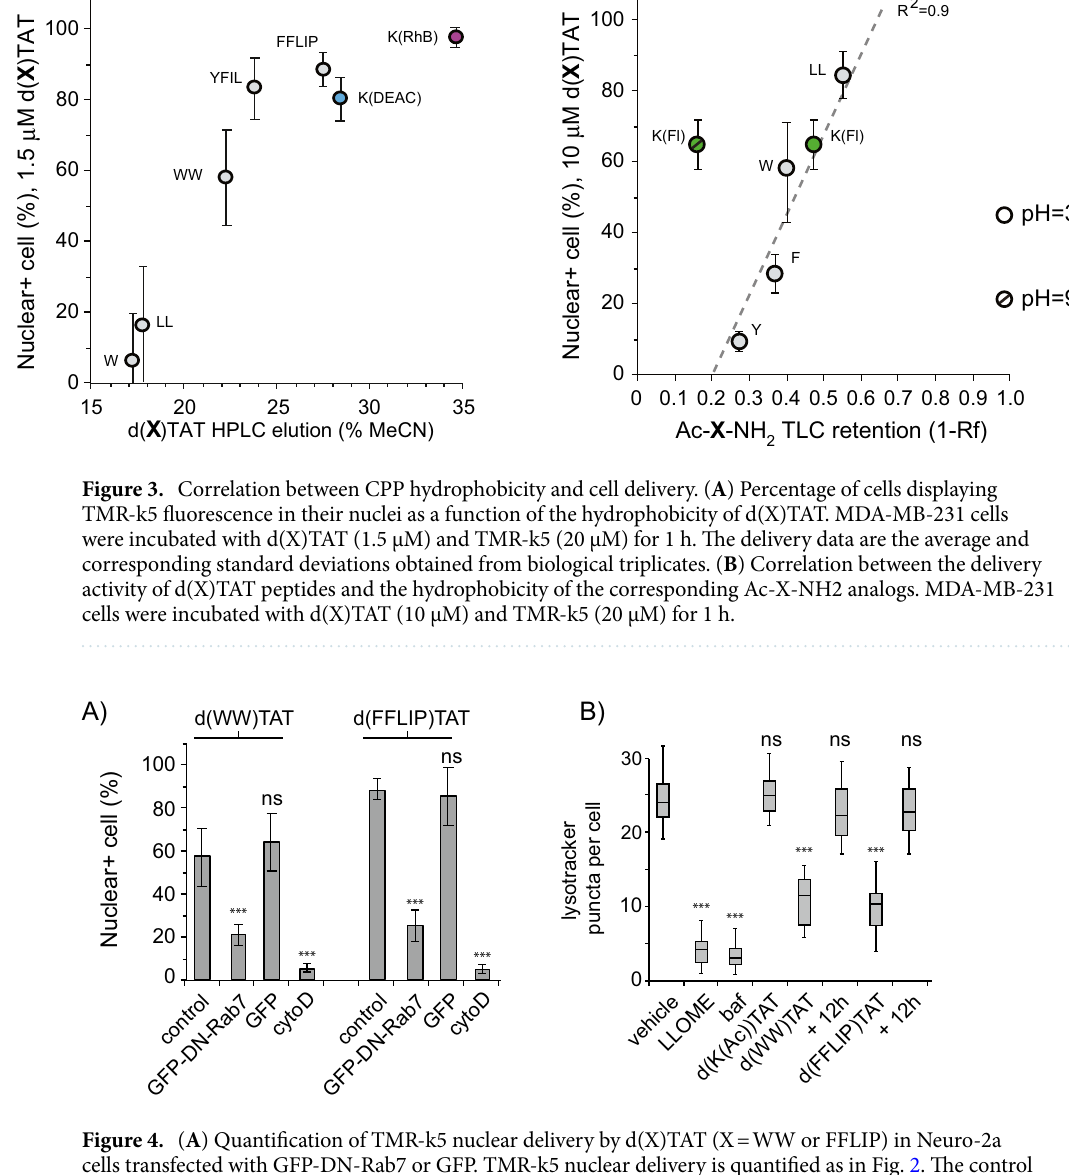
Figure 4. ( A ) Quantification of TMR-k5 nuclear delivery by d(X)TAT (X = WW or FFLIP) in Neuro-2a cells transfected with GFP-DN-Rab7 or GFP. TMR-k5 nuclear delivery is quantified as in Fig. 2. The control condition represents non-transfected cells. The data represents the average of biological triplicates and the corresponding standard deviations. The label ns corresponds to p > 0.05, *** corresponds to p < 0.001, p values being determined using a two-tailed t test. ( B ) Quantification of lysotracker-green stained puncta before and after incubation with d(X)TAT (X = K(Ac), WW, or FFLIP) at 10, 1.5, and 1.5 μM, respectively) for 1 h. After washing, cells are stained with LysoTracker Green DND-26 (500 nM) for 5 min. The number of green puncta in cells imaged at ×100 magnification is then counted in 100 cells per experiment. The data are represented as box-and-whisker plots, obtained from biological triplicates. Controls include LLOME, a compound that causes endosomal membrane damage, and bafilomycin, an inhibitor of the vacuolar H + ATPase. For cells incubated with d(X)TAT peptides, the number of lysotracker puncta was established 1 h or 12 h after incubation to assess cell